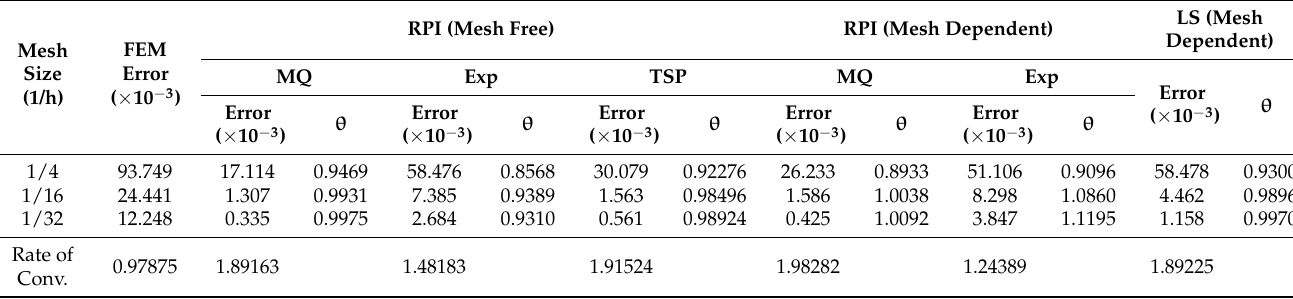
Table 4. Error convergence and global effectivity ( θ ) obtained for RPI with radial basis function types and least square based displacement recovery techniques (linear triangular, energy norm).